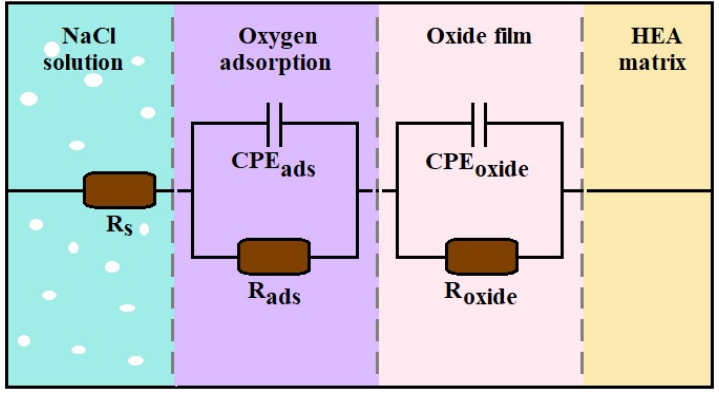
Figure 7. ( a ) The Bode plots and ( b ) Bode phase plots of CrFeCoNi and CrFeCoNiSn alloys in 0.6 M NaCl solution at ambient temperature.